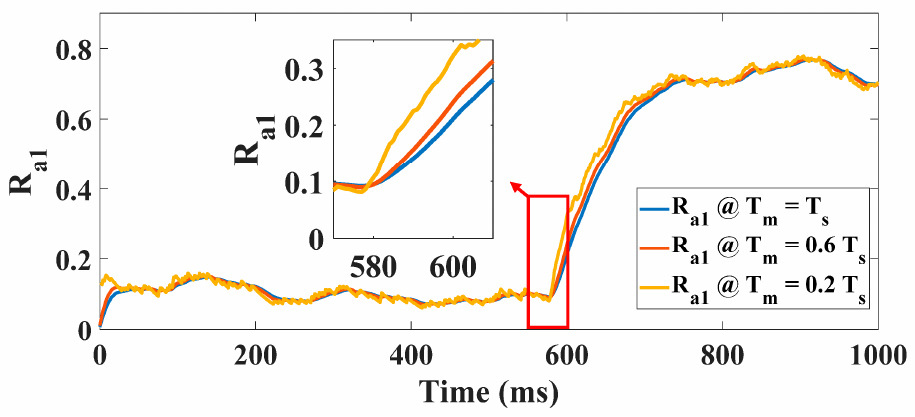
Figure 7. Effect of changing the moving average period ( 𝑇 (cid:3040) ).